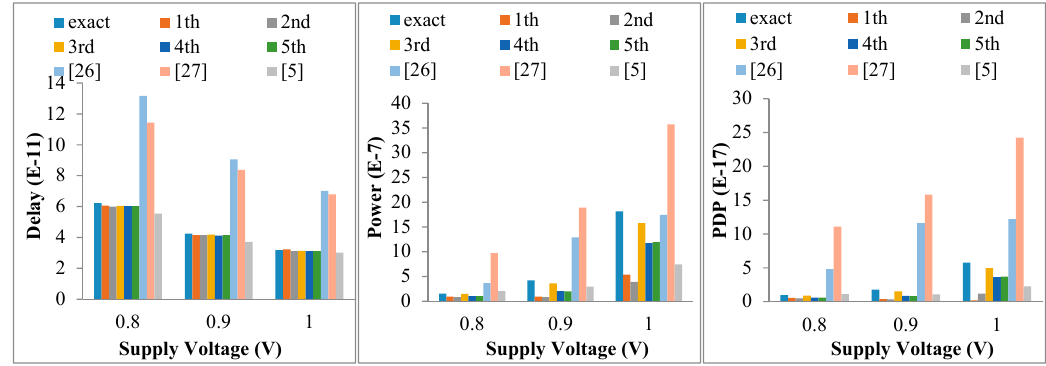
Figure 9. Operation of the proposed methods under supply voltage variations.